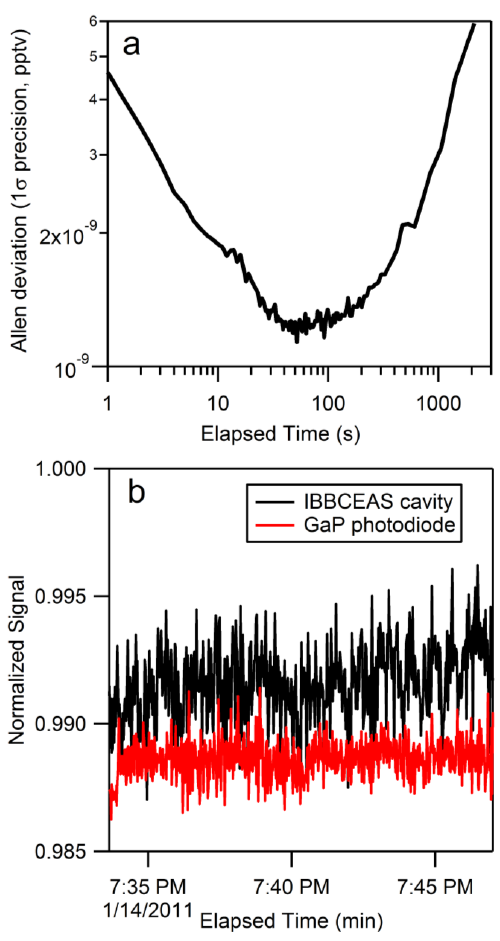
Fig. 3. (a) Allan deviation plot of the optical density of the IB- BCEAS for a single pixel at 370nm in the 365nm channel. The Figure 3. (a) Allan deviation plot of the optical density of the IBBCEAS for a single pixel at 370 605 minimum near 5min, was selected as the optimum sampling time nm in the 365 nm channel. The minimum near 5 min, was selected as the optimum sampling 606 between zeros. (b) Stability of the 365nm LED intensity measured using a GaP photodiode, shown together with the stability of the time between zeros. (b) Stability of the 365 nm LED intensity measured using a GaP photodiode, 607 IBBCEAS cavities for a single pixel at shown together with the stability of the IBBCEAS cavities for a single pixel at 376 nm. 608